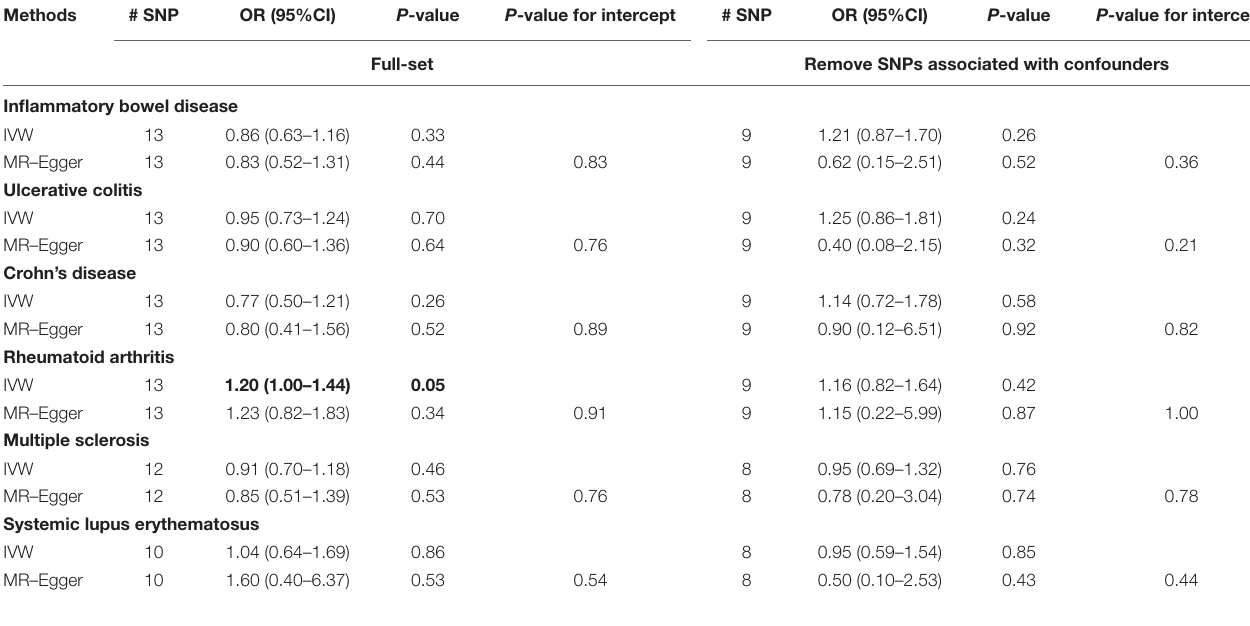
TABLE 4 | The association between genetically predicted levels of harmful alcohol consumption (alcohol use disorder identification test score) and risk of common autoimmune inflammatory diseases.